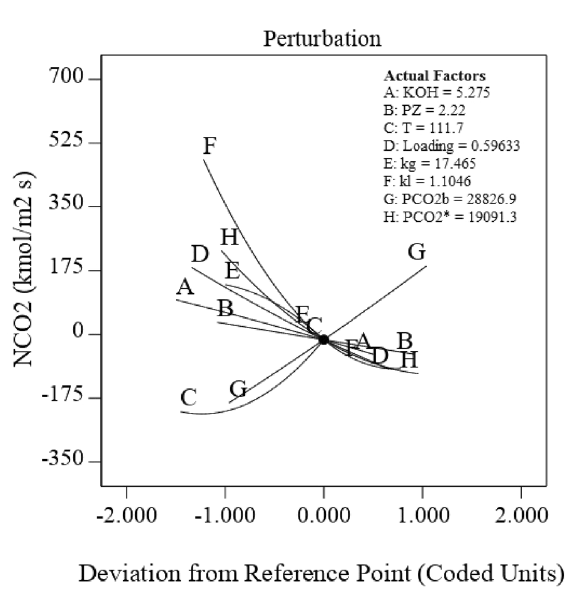
Figure 5. Deviation curves for CO 2 mass transfer flux with coded